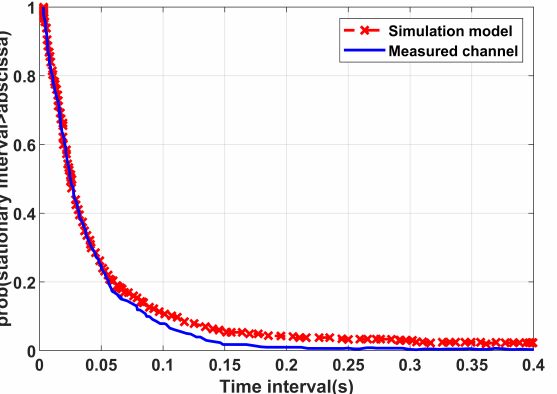
Figure 9. The CCDF of the stationary interval simulated results and the measured results.